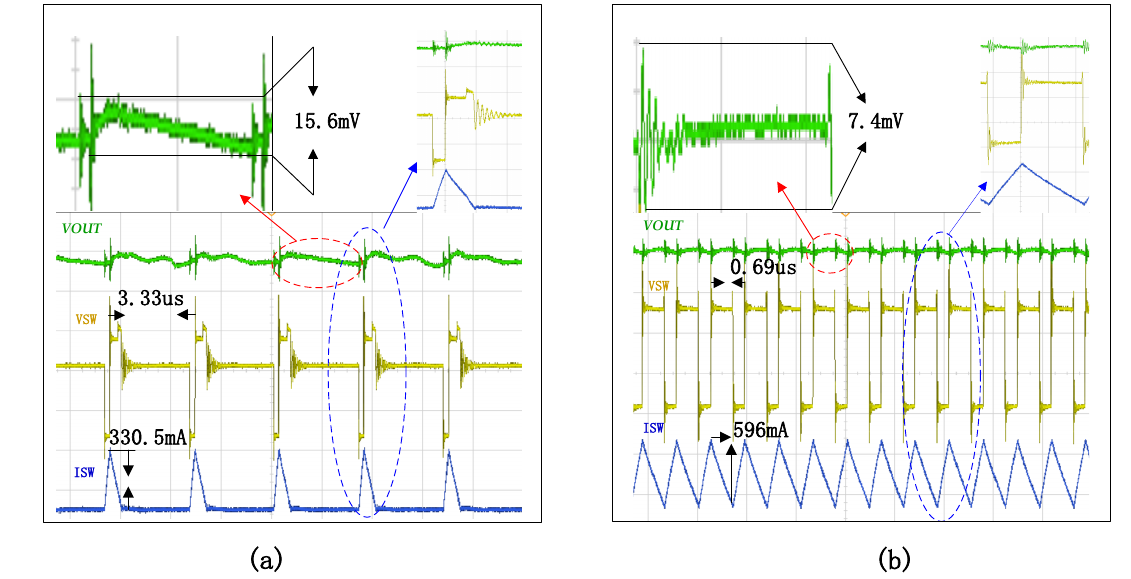
Figure 15. Experimental results of output voltage VOUT , inductor terminal voltage VSW and inductor current ISW for stable operation of the boost converter at input voltage VIN = 3.6 V. ( a ) The load current ILOAD = 30 mA. ( b ) The load current ILOAD = 200 mA.